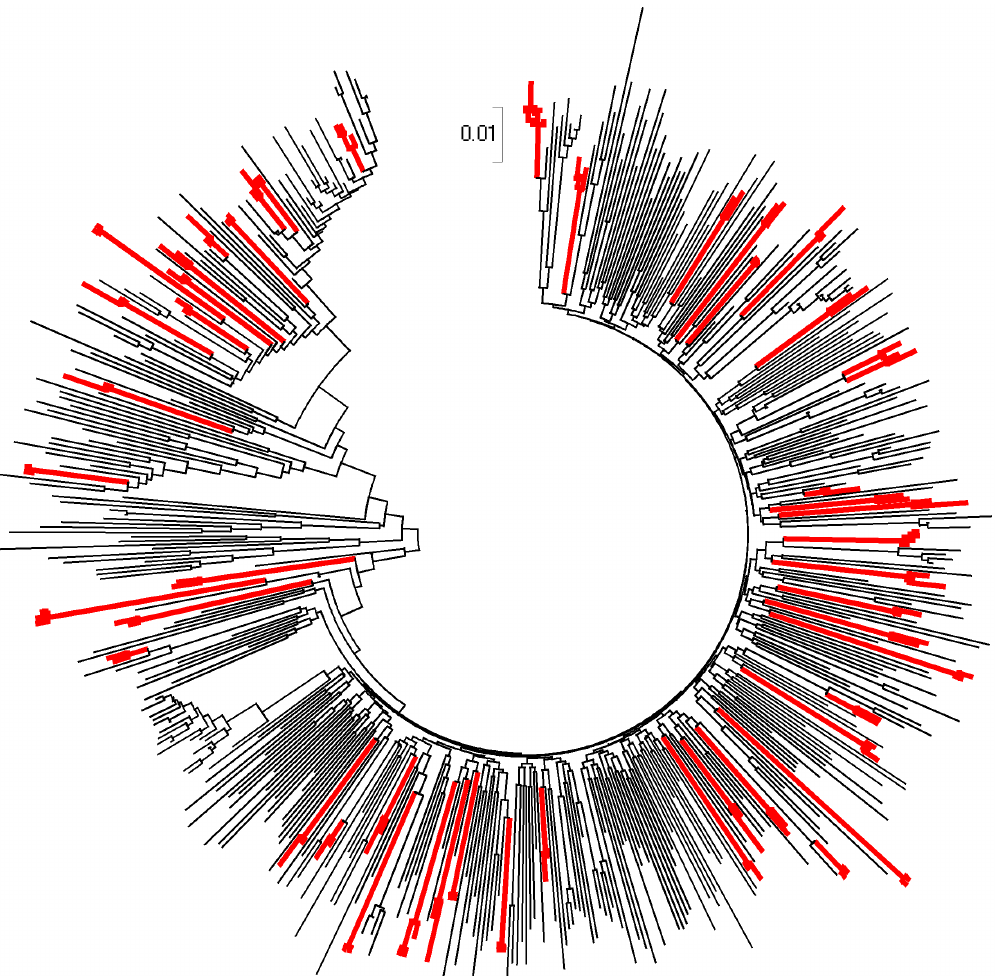
Fig 1. Phylogenetic tree of the entire population. The evolutionary history was inferred using the Neighbour-Joining method [17]. The optimal tree with the sum of branch length = 11.53297849 is shown. The tree is drawn to scale, with branch lengths in the same units as those of the evolutionary distances used to infer the phylogenetic tree. The evolutionary distances were computed using the Maximum Composite Likelihood method and are in the units of the number of base substitutions per site. All positions containing alignment gaps and missing data were eliminated only in pairwise sequence comparisons. There were a total of 1308 positions in the final dataset. Branches corresponding to clusters are in